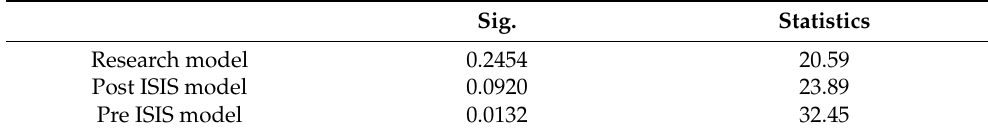
Table 7. The results of the Hausman